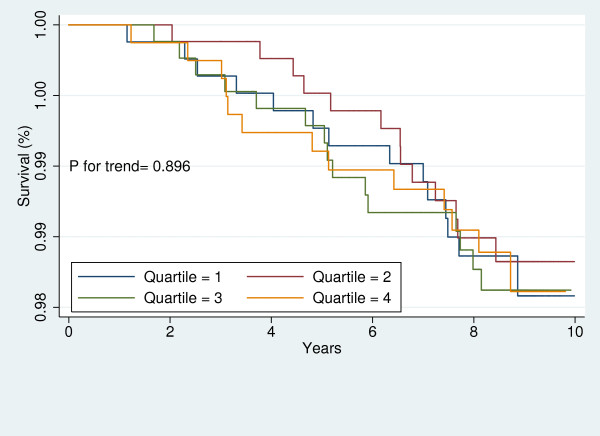
Kaplan-Meier curves for all-cause mortality across LAP quartiles in women with global CVD risk less than 20%.